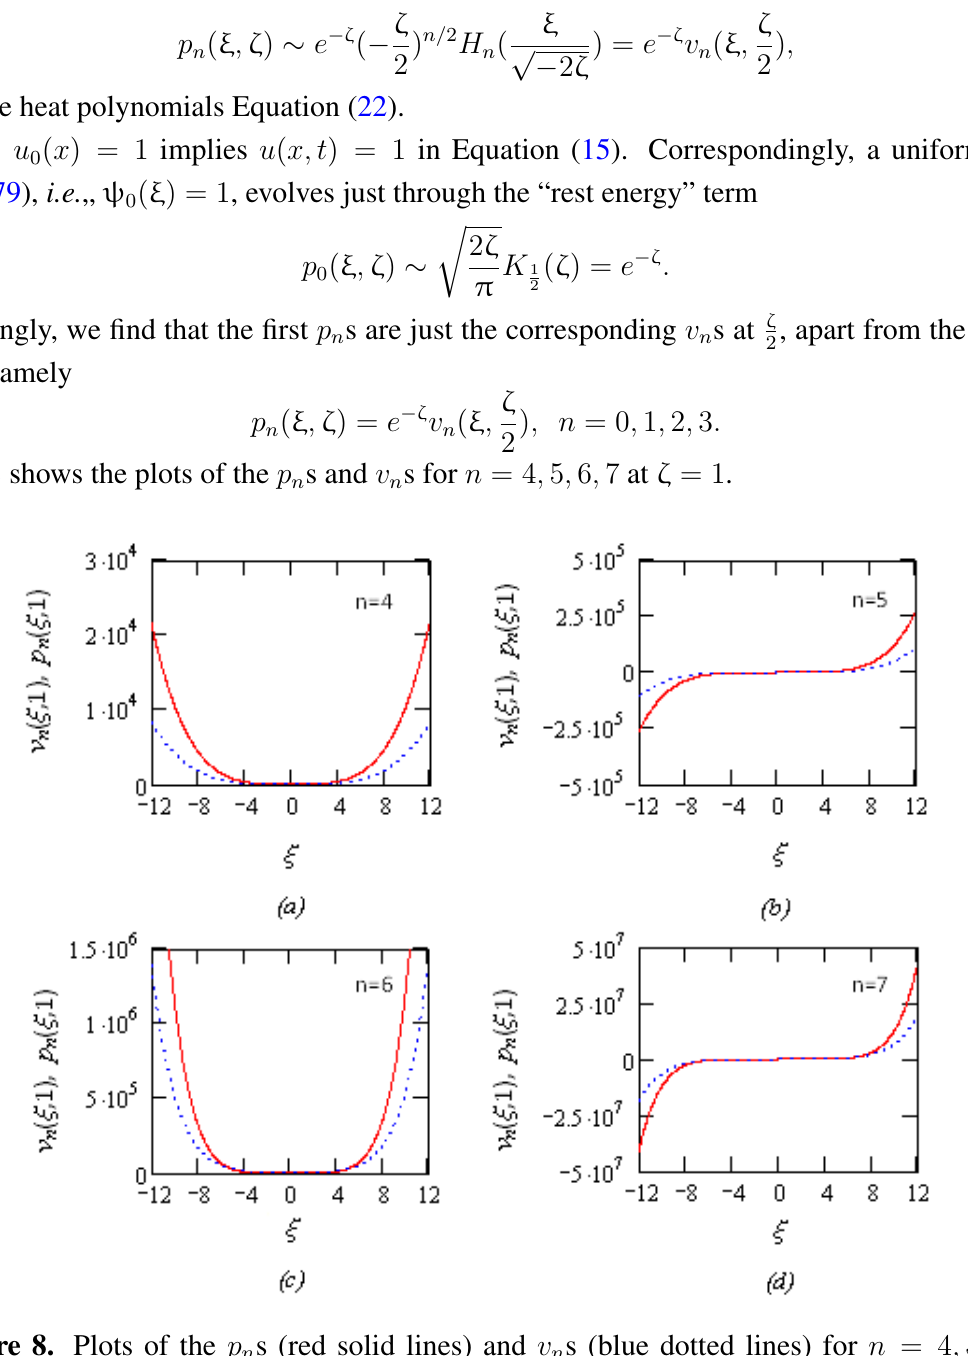
s (red solid lines) and v n